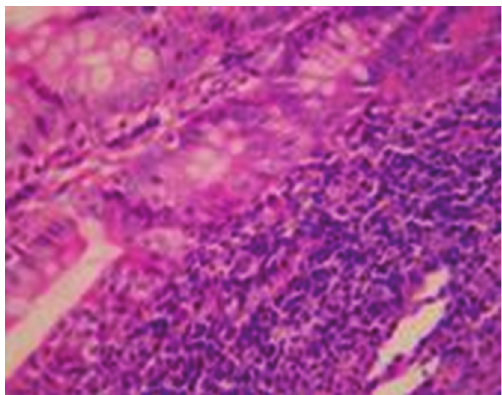
Figure 2: Model control group-28d a large inflammatory cells infiltration in small intestinal wall HE × 200.